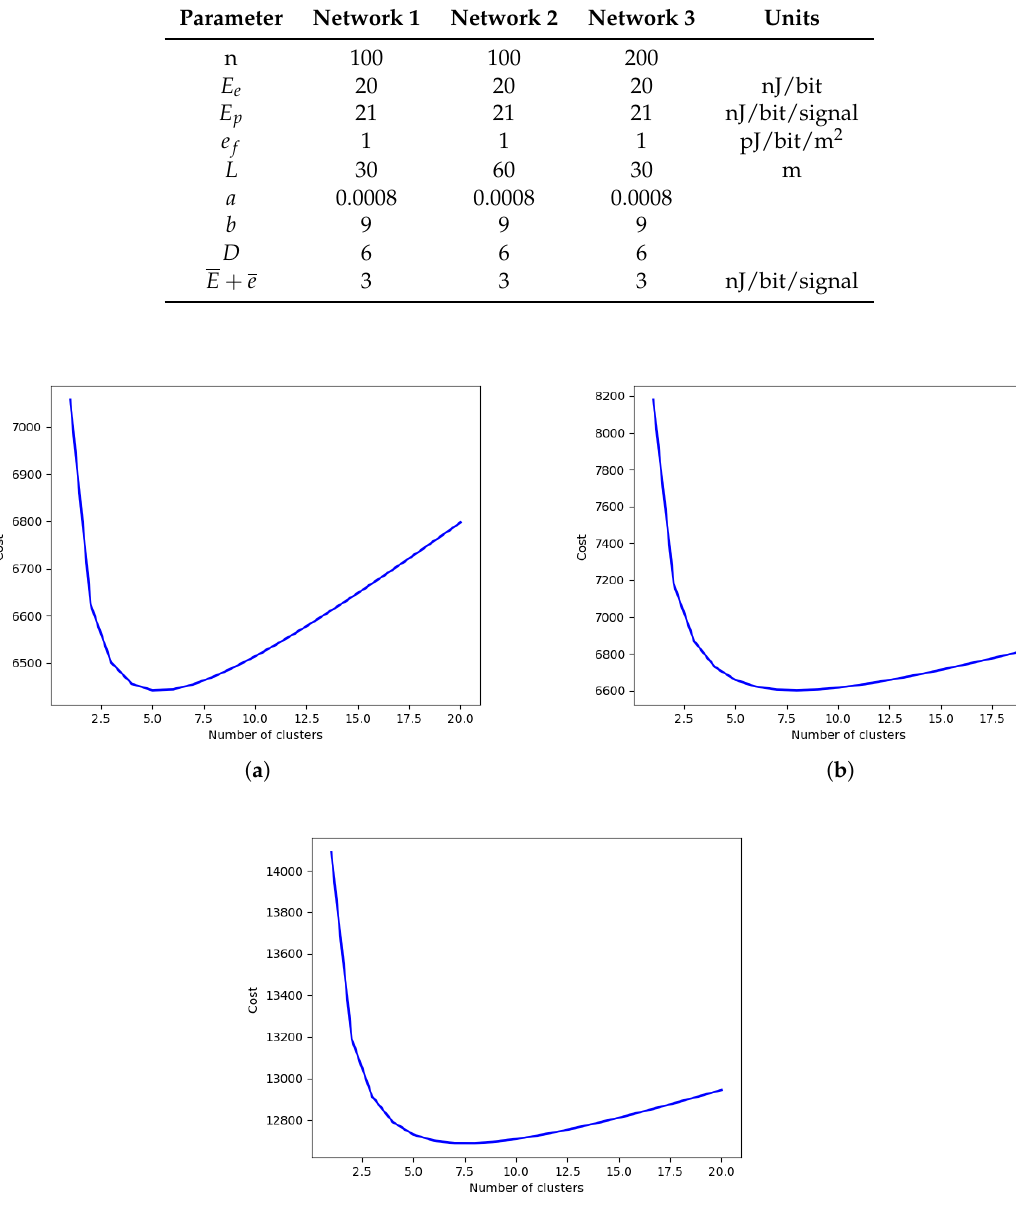
Table 1. Parameters and their corresponding values.